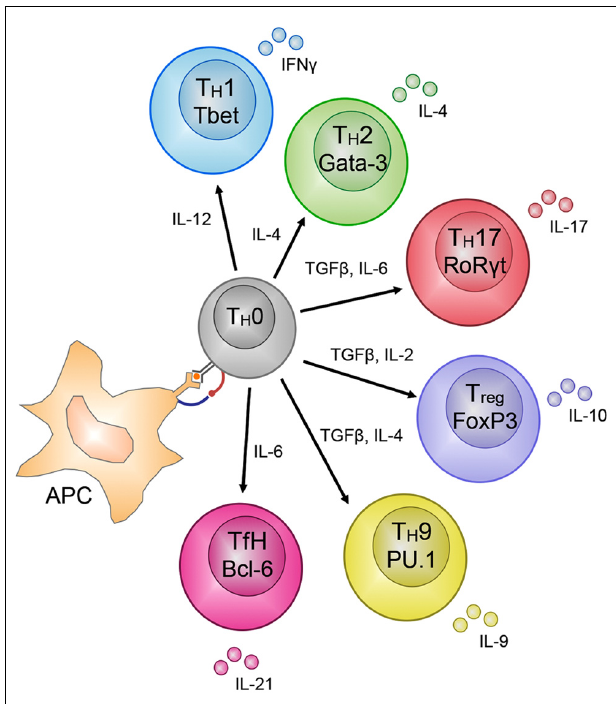
FIGURE 2 | CD4 + T H – cell subset differentiation. CD4 + T cells show remarkable plasticity and are able to differentiate into many different subsets based on the soluble molecules secreted during priming of the subsets by antigen presenting cells (APC), e.g., IL-12 forT H 1 cells.The different subsets can be distinguished by the transcription factors that regulate and maintain their lineage-specific effector functions, e.g.,T-bet for T H 1 cells.The molecules secreted by these subsets, e.g., IFN- γ forT H 1 cells, are finely tuned to control the pathogen that mediated the release of the specific molecules by the APC during activation of theT H 0 cells into the various